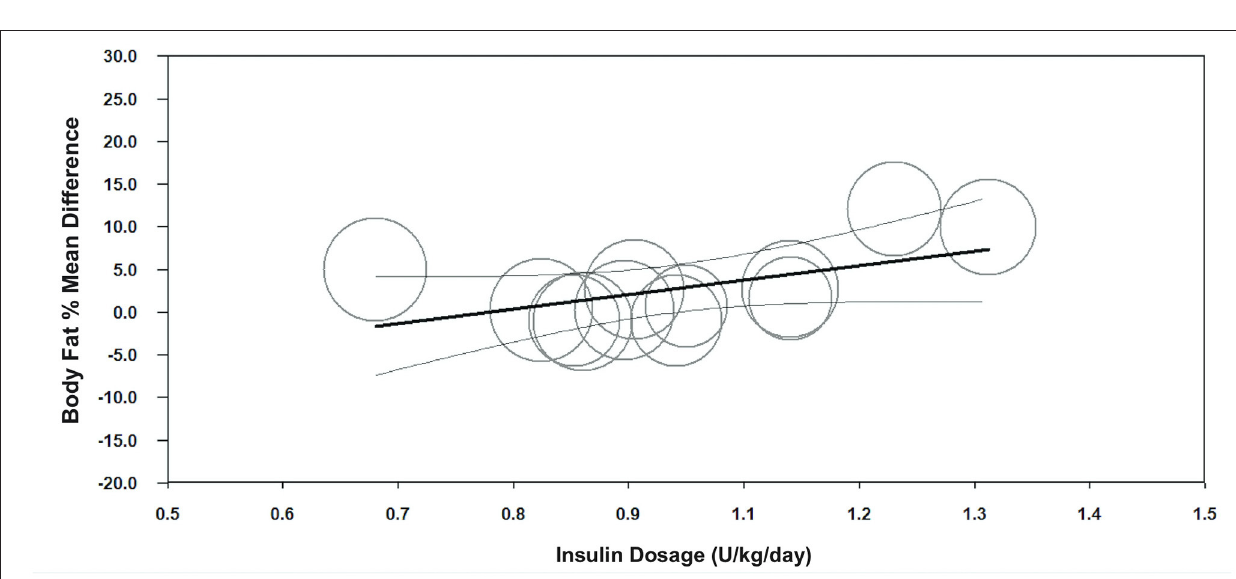
FIGURE 4 | Meta-regression graph illustrating the association between insulin dosage (U/kg/day) and body fat % mean difference, with 95% confidence intervals (CI) of body fat % compared children with T1D to TDC. The size of the circles represents the weight given to each individual study in the meta-analysis. Larger circles indicate a higher